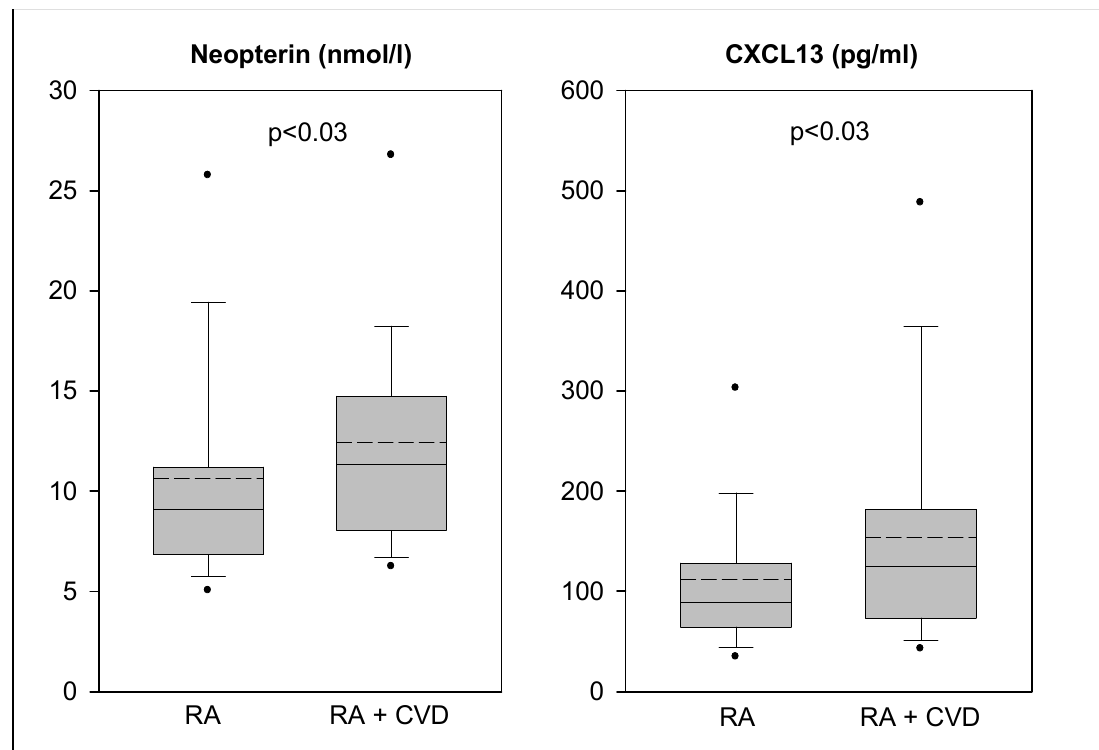
Figure 1: Neopterin and CXCL13 concentrations in patients with RA (n = 85) and in patients with RA plus car- diovascular diseases (CVD) (n = 28); boxplots show medians (horizontal lines), mean values (dotted lines) and 5 th - 95 th percentiles (dots); p =